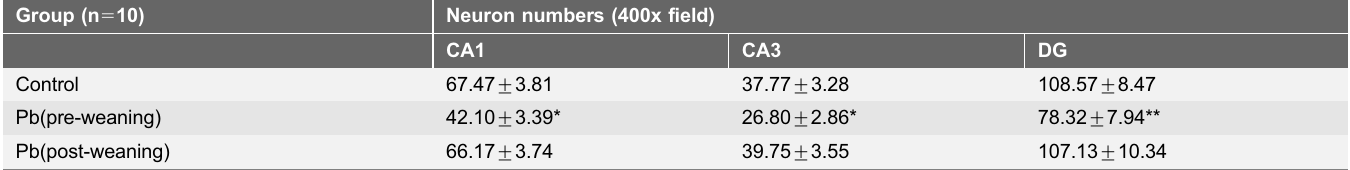
Table 3. The effect of developmental lead exposure on the number of neurons in the rat hippocampus on PND 84. Group (n 5 10)